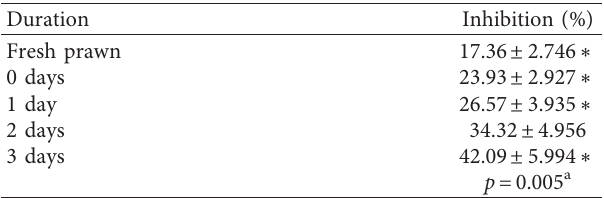
Table 2: Results of IC 50 (ppm) of fermented shrimp sausages at different fermentation times.